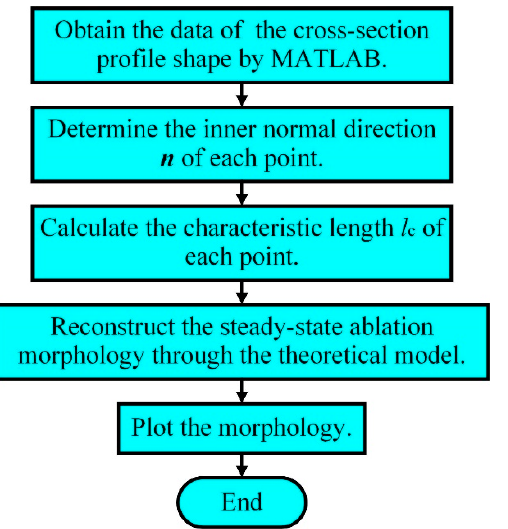
Figure 5. Flow chart of the calculation process of the steady-state ablation morphology.